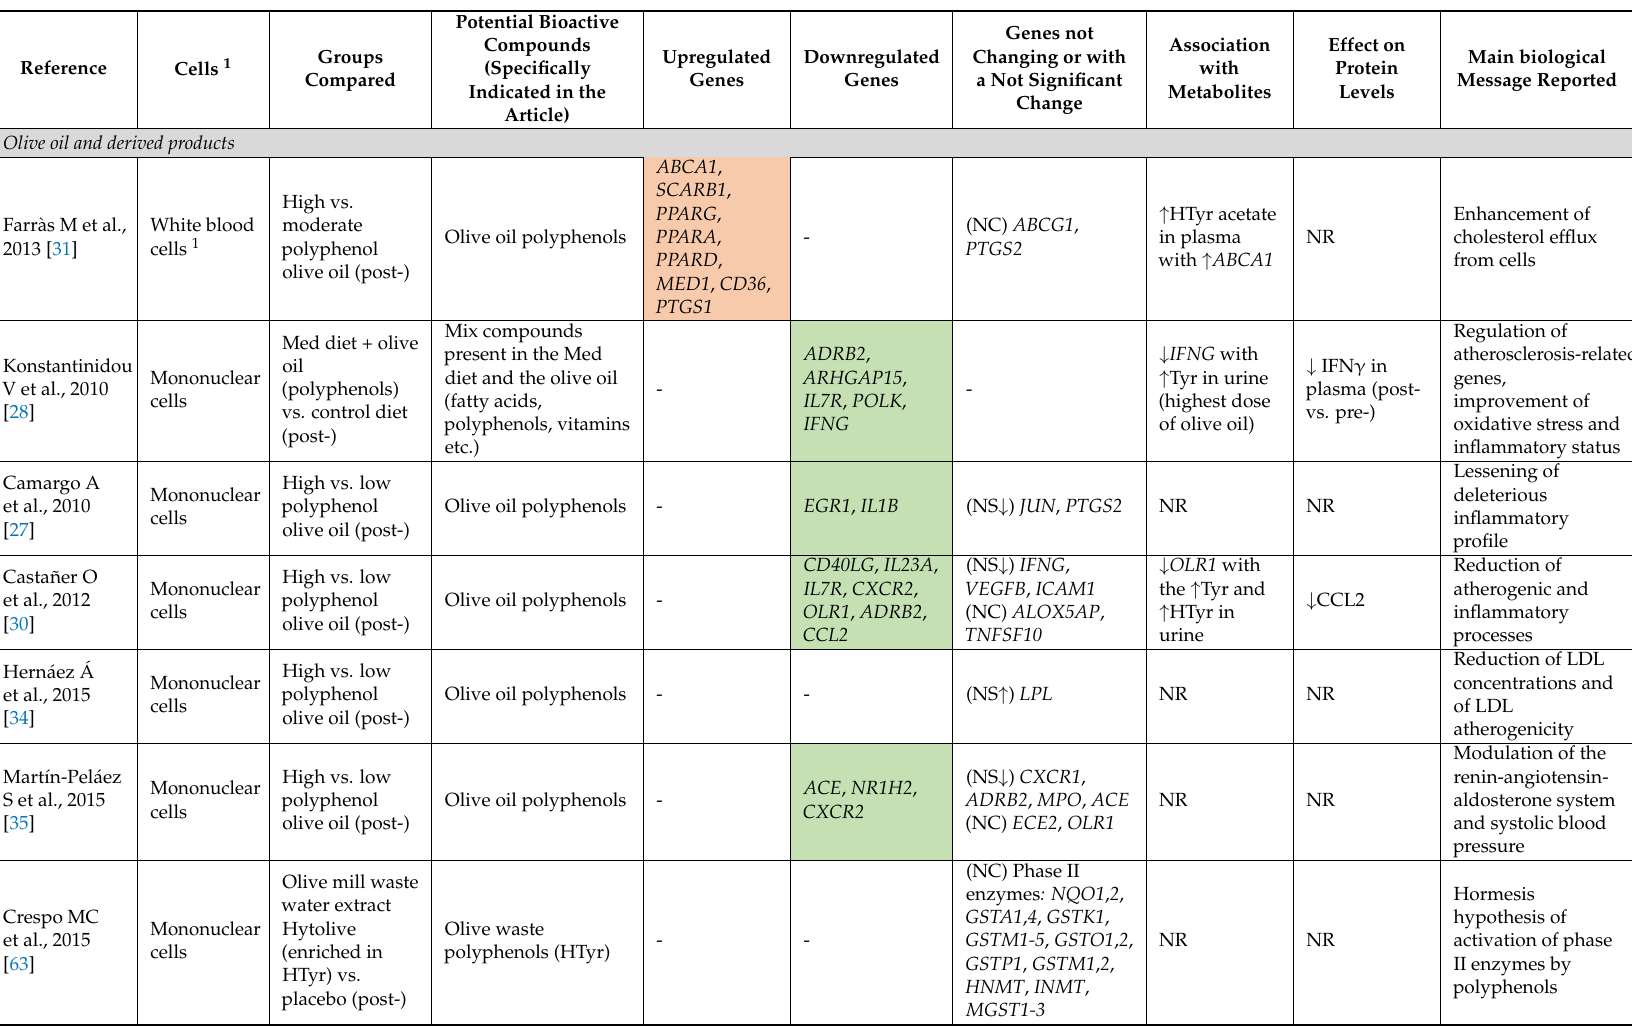
Table 4. Overview of the significant gene expression changes attributed to the intervention with specific foods or derived products containing bioactive compounds and reported in different cells and tissue samples ( p -value <